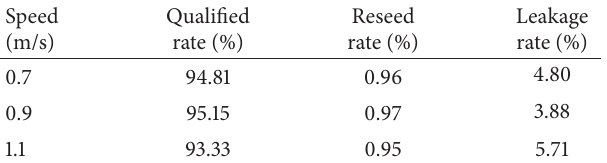
Table 8: Results under different speed.